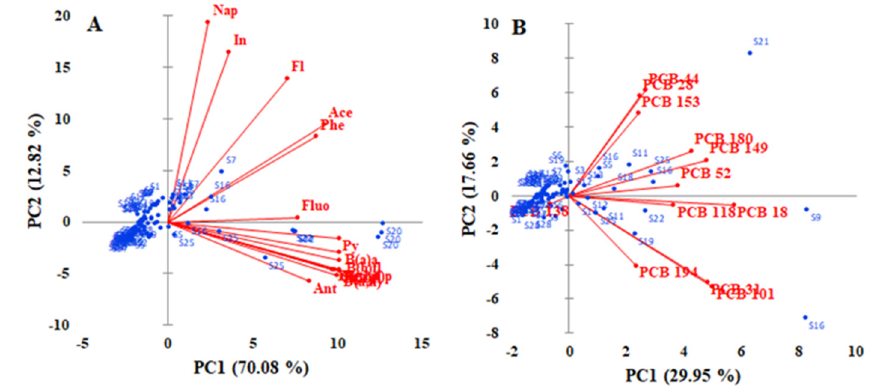
Figure 1. Principal component analysis (PCA) analysis for concentrations of: polycyclic aromatic hydrocarbons (PAHs) ( A ) and of polychlorinated biphenyls (PCBs) ( B ) in surface sediments of the Olt